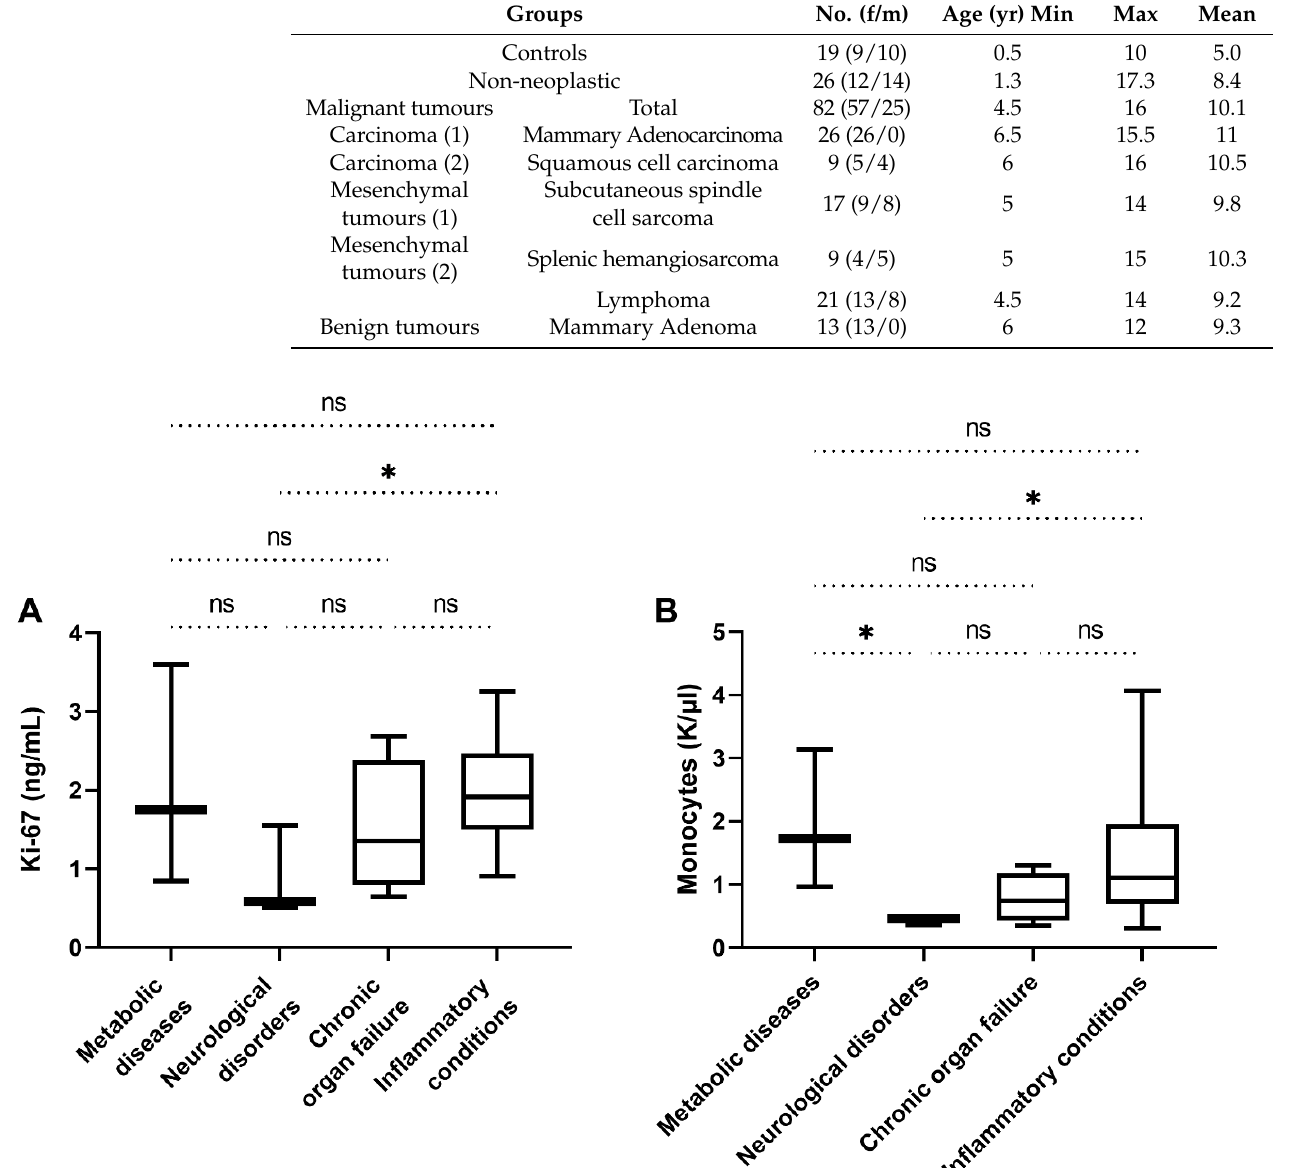
Table 2. Number, sex, and age of all dogs investigated in this study.